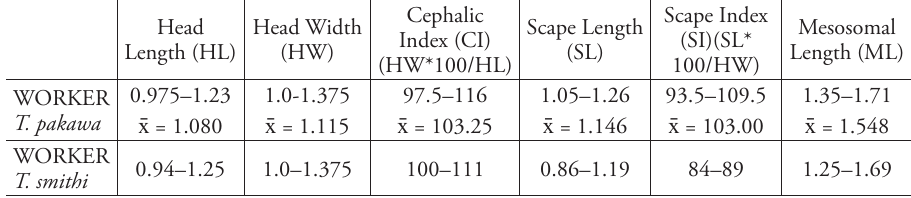
Table 2. Dimensions (mm) of morphological features of the worker caste of Trachymyrmex pakawa (n = 22) and Trachymyrmex smithi